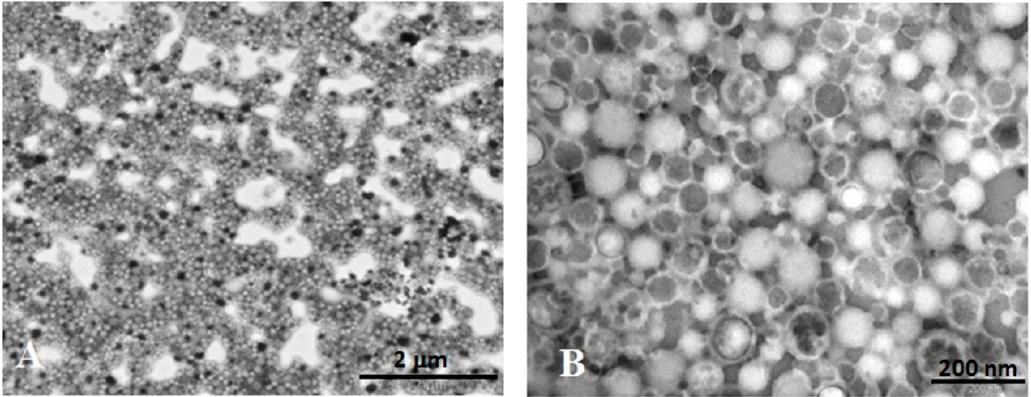
Figure 2. Ultrastructural morphology of negatively stained ICG-NPs1. ( A ) ICG-NPs1 appeared as aggregates creating a sort of network irregularly shaped (magnification: 12,000×; scale bar: 2 µm). ( B ) ICG-NPs1 appeared distinct in three different types for the morphology, dimension, and electron density (magnification: 100,000×, scale bar: 200 nm).